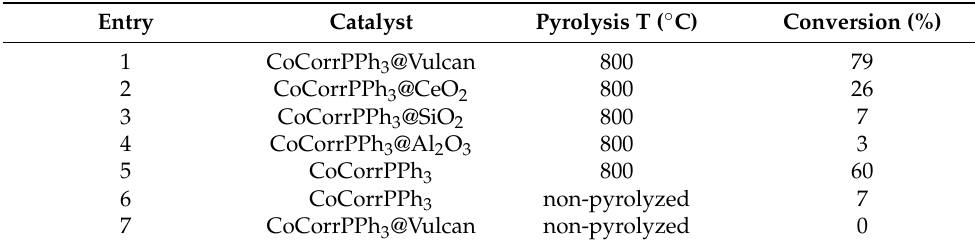
Figure 5. Model hydrogenation of nitrobenzene to aniline effected by CoCorrPPh 3 @Vulcan. Table 1. Dependence of the catalyst activity on the chemical nature of the support. Reaction condi- tions: nitrobenzene (0.25 mmol), catalyst (0.5 mol%), H 2 (40 bar), MeOH (2 mL), 120 °C, 16 h, and n -hexadecane as an internal standard (18 mg). The indication of the catalyst quantity is based on the bulk metal content as determined by the elemental analysis.